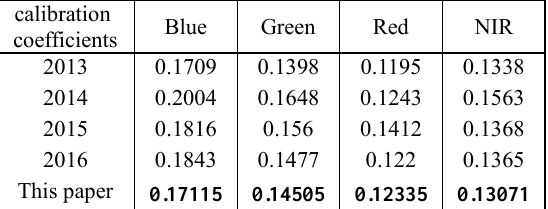
Table 5. The comparision of calibration